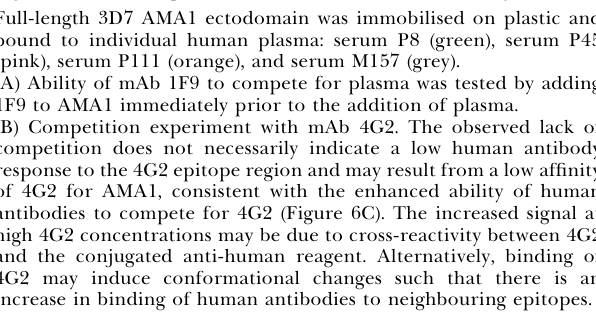
Figure S1. 1F9 Competes with Human Plasma for Binding to AMA1